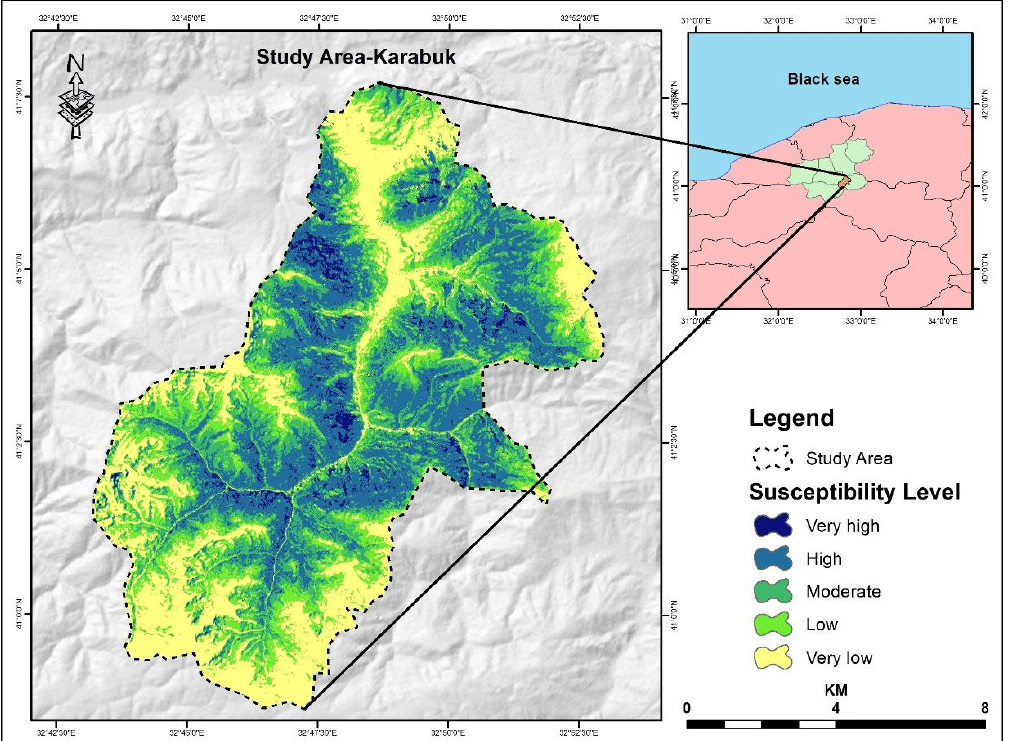
Figure 4 Susceptibility valuation outcomes of landslides based on FFNN predictor.